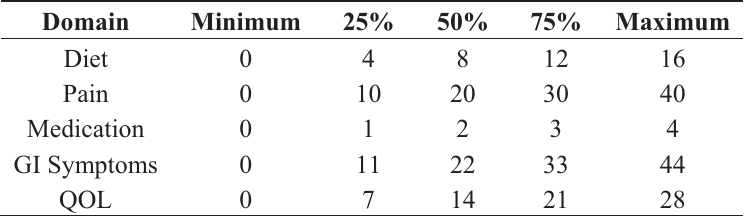
Table 5. Domain quartiles for each measured domain in the SBO QOL questionnaire based upon one standard deviation in a normal population.